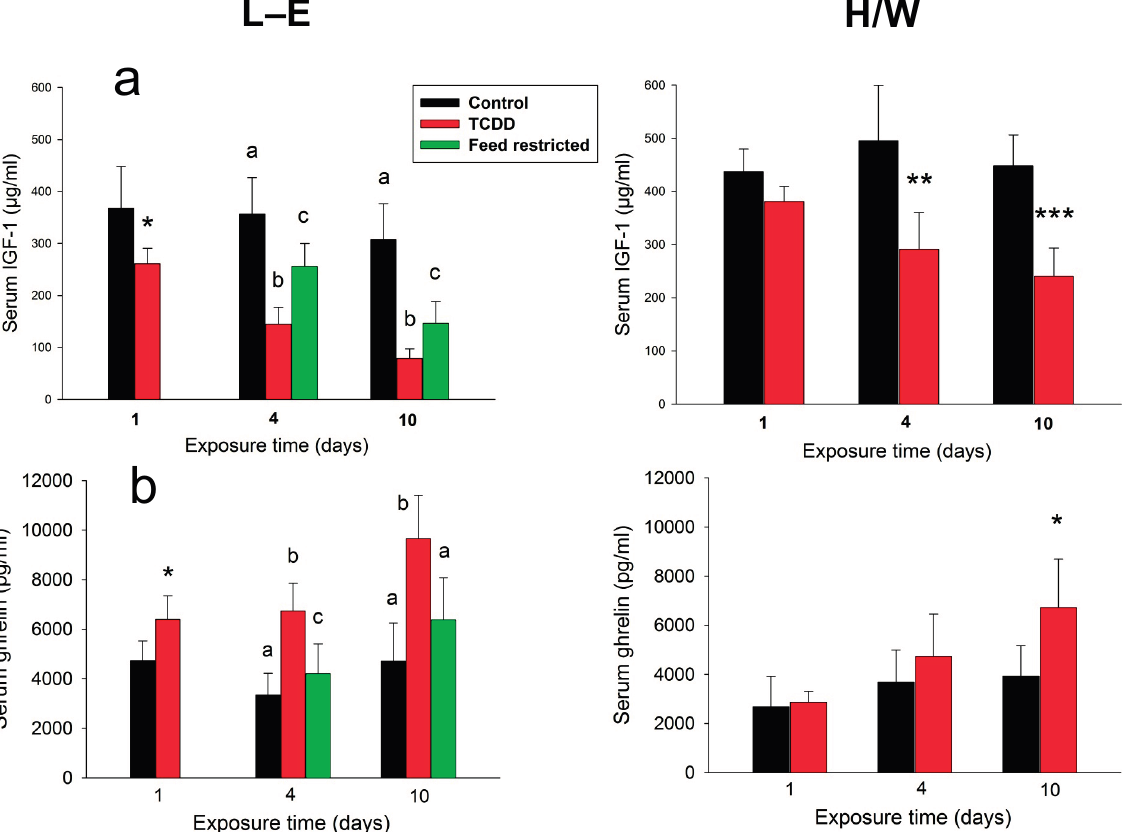
Figure 4. The effect of TCDD or feed restriction on ( a ) serum IGF-1 and ( b ) ghrelin concentrations in L-E ( left panel) and H/W rats ( right panel) as a function of time (mean ± SD). The conditions are as in Figure